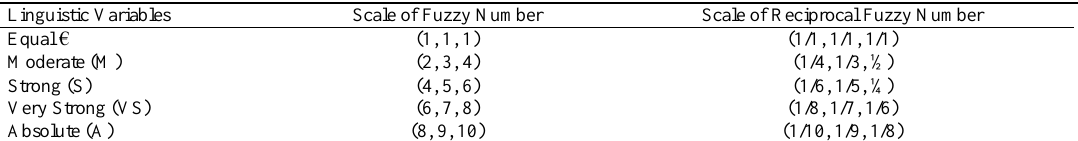
Table 2. Comparison scale